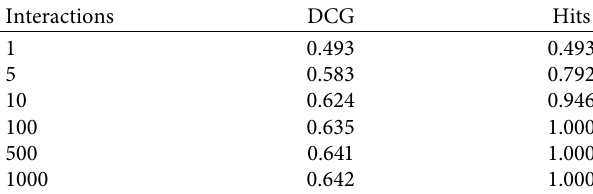
Table 5: Metric DCG and Hits for Scenario 2.